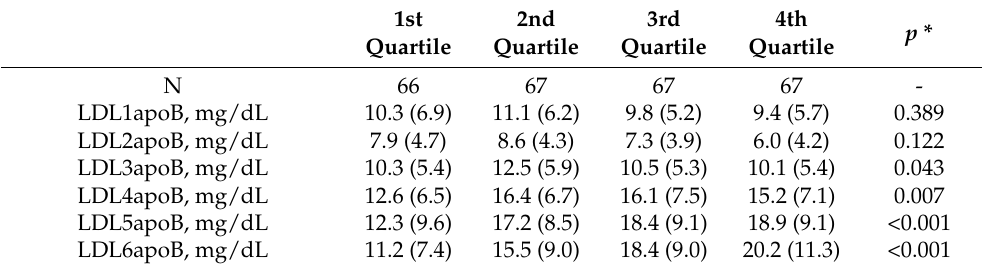
Table 5. LDLapoB in LDL subclasses according to LDLapoB/LDLC calc